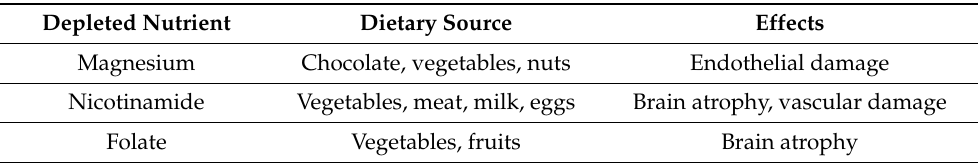
Table 3. Dietary factors involved in Alzheimer’s